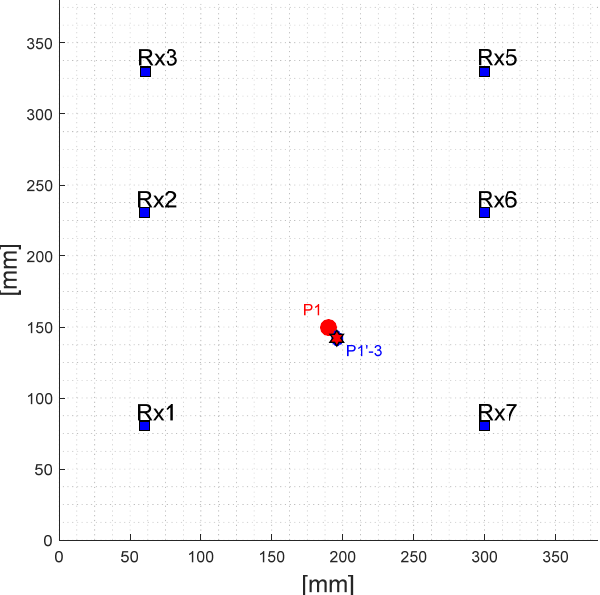
Figure 10. Position of impact P1 (red circle) inside the ROI with coordinates x i = 190 mm, y i = 150 mm. The detected impact position P1 ′ -3 (red star) with coordinates x p = 196 mm, y p = 142 mm was obtained by processing the ultrasonic signals acquired by six sensors (Rx1, Rx2, Rx3, Rx5, Rx6, and Rx7).